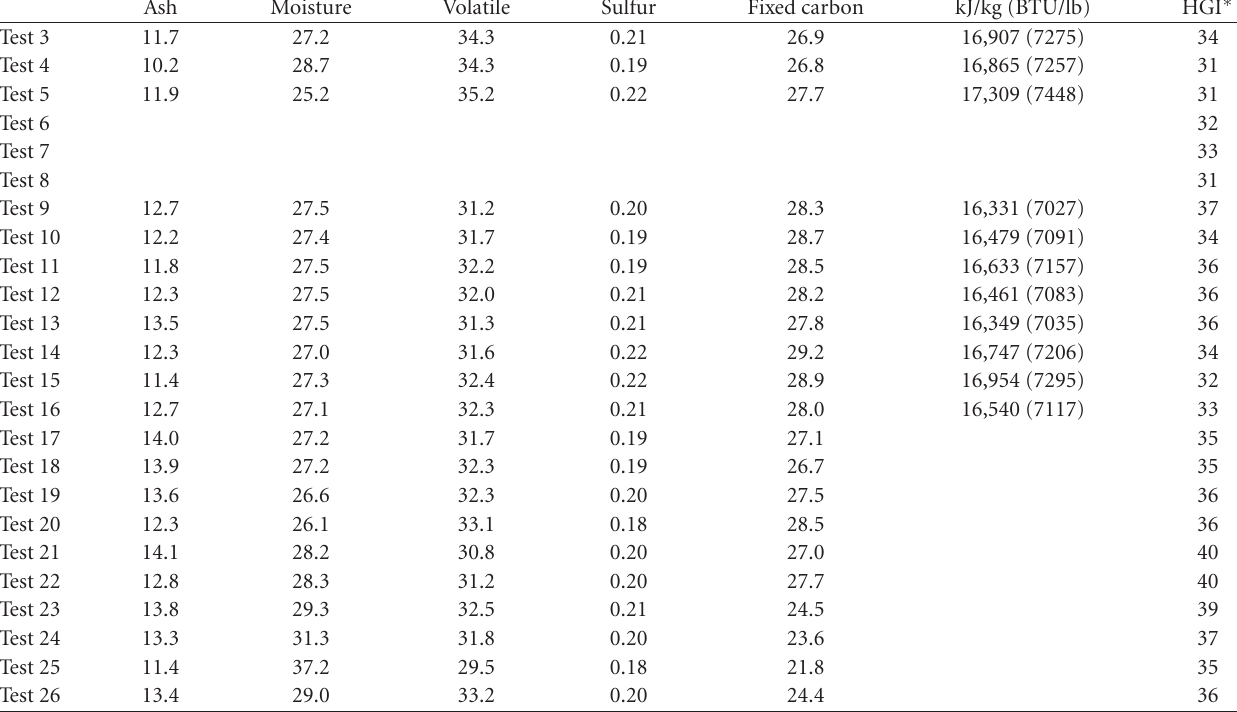
Table 1: Raw coal quality data (as received).